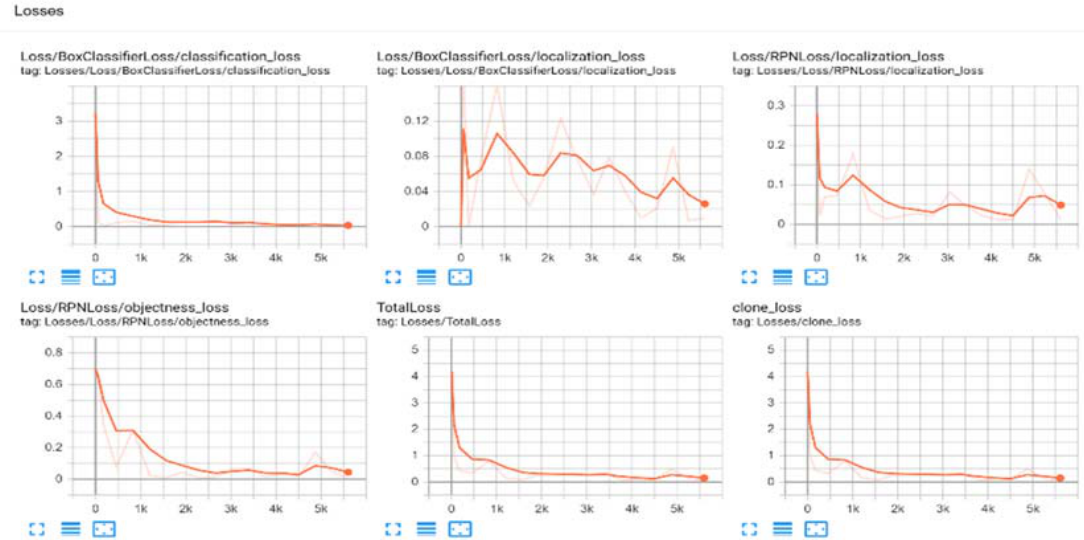
Figure 6. Graphical results of the proposed model.